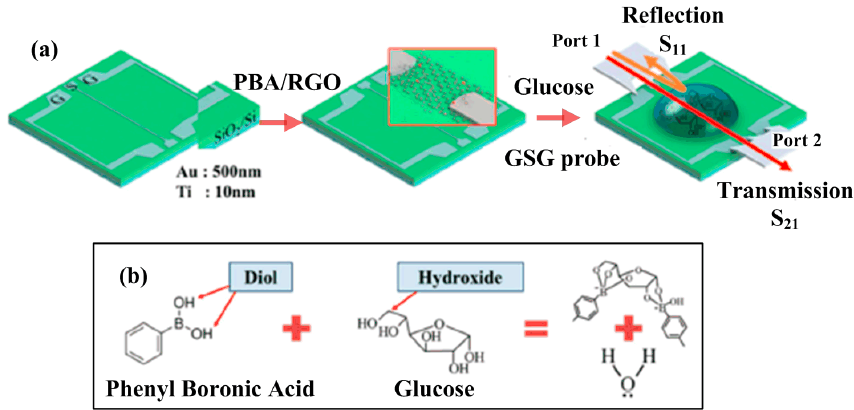
Figure 7. RF/microwave biosensor based on rGO for sensing of glucose molecule: ( a ) Schematic diagram of glucose sensor; ( b ) Glucose binding to the phenyl butyric acid (PBA) linker (reprinted with permission from [89]). Table 3. Types of rGO or GO-based RF/microwave biosensors.